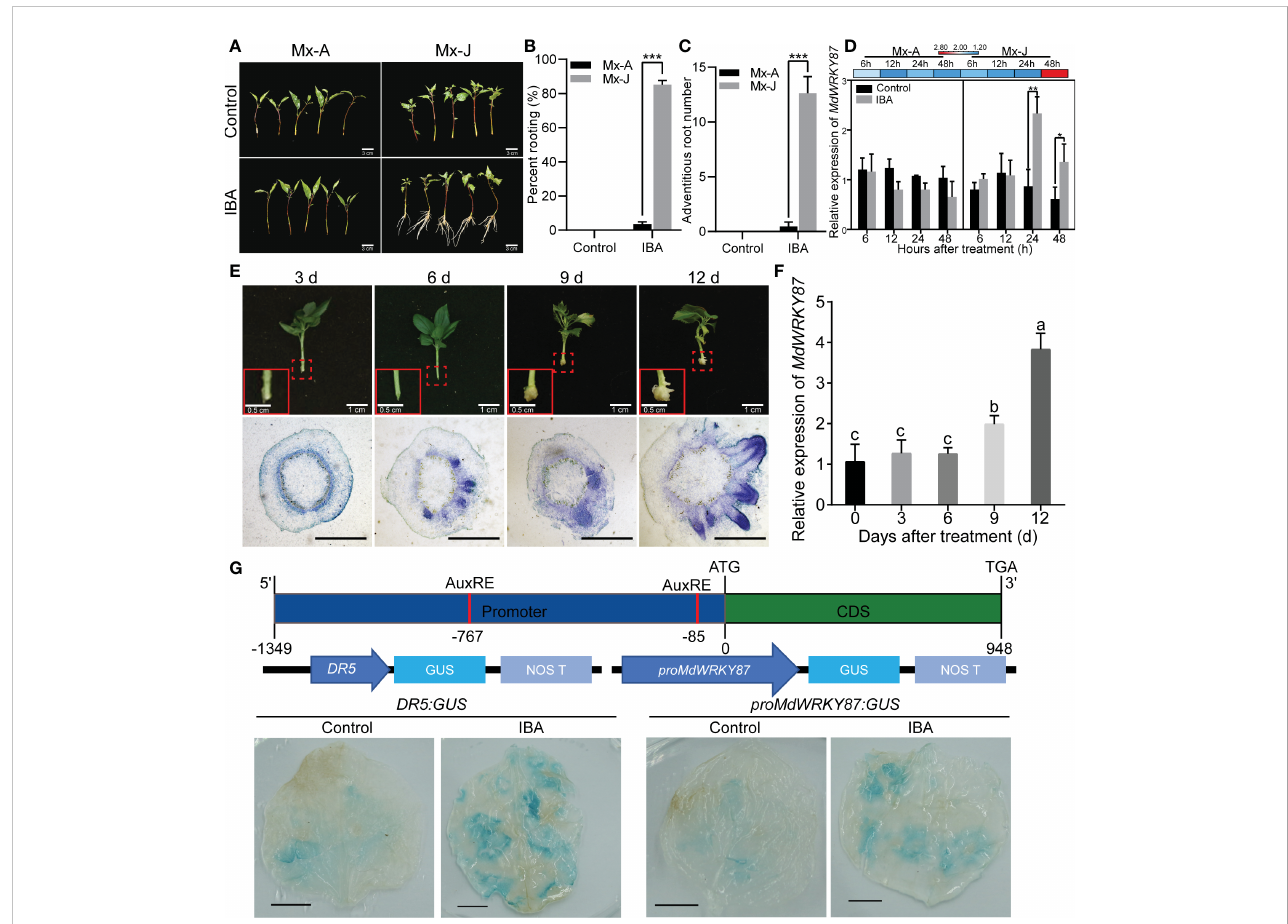
FIGURE 1 The expression of MdWRKY87 is positively correlated with auxin-induced adventitious root formation. (A) Indole butyric acid (IBA) treatment induced adventitious root formation of leafy cutting from juvenile (Mx-J) not adult (Mx-A) phase in M. xiaojinensis . Scale Bar = 3 cm. (B) Adventitious rooting percentage of leafy cutting from Mx-A and Mx-J phase of M. xiaojinensis after IBA treatment. (C) Number of adventitious roots. For B and C, the mean values ± SD are shown for three biological replicates. Student ’ s t -test, *** P < 0.001. (D) Relative expression of MdWRKY87 gene in leafy cutting of Mx-A and Mx-J after IBA treatment. The mean values ± SD are shown for three biological replicates. Stem bark samples of 0.5 to 1.0 cm basal sections of 20 Mx-J or Mx-A cuttings treated with IBA-free solution or IBA were pooled together as one biological replicates. Student ’ s t -test, ** P < 0.01. (E) The process of adventitious root formation of tissue culture plantlets growing on 1/2 MS medium containing IBA. Top, representative pictures of adventitious root formation of plantlets. The red dotted boxes indicate portion of stem base magni fi ed in red solid line boxes (Scale bar = 0.5 cm). Scale bar = 1 cm. Bottom, transverse sections of stem base during the adventitious root formation. Scale bar = 1 mm. (F) Relative expression of MdWRKY87 gene in stem base of tissue culture plantlets. Different letters indicate statistically signi fi cant differences ( P < 0.05) at by Duncan ’ s test. (G) GUS activity of N. benthamiana leaves transiently transformed with proMdWRKY87:GUS or DR5:GUS after IBA treatment. Top, schematic representation of MdWRKY87 . Medium, schematic representation of the proMdWRKY87:GUS and DR5:GUS constructs. Bottom, GUS activity analysis. Scale bar = 1 cm. *p <